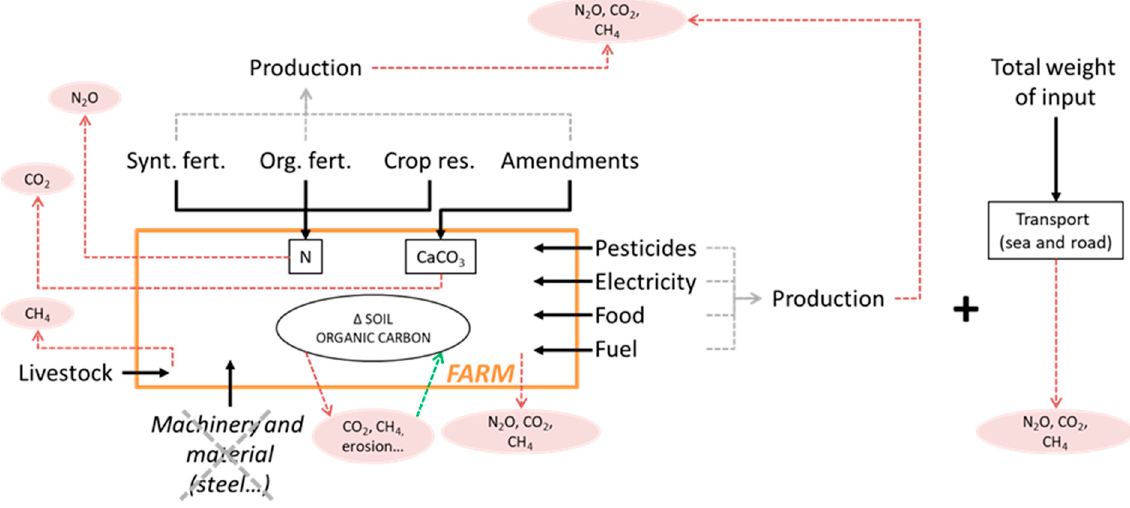
Figure 3. Description of the gas flows that were taken into account for estimating greenhouse gas emissions (“GHG emissions”) of the farm represented with the orange line. Black, green and red dotted arrows refer to inputs, gas emissions and CO 2 sequestration respectively. Synt. Fert., Org. fert. and Crop res. refer to Organic fertilizers, Synthetic fertilizers and Crop residues respectively. The variation ( ∆ ) of soil organic carbon was accounted for separately with the indicator “SOC vari- ation”. Emissions related to machinery and other materials (crossed out in gray) were not taken into account.